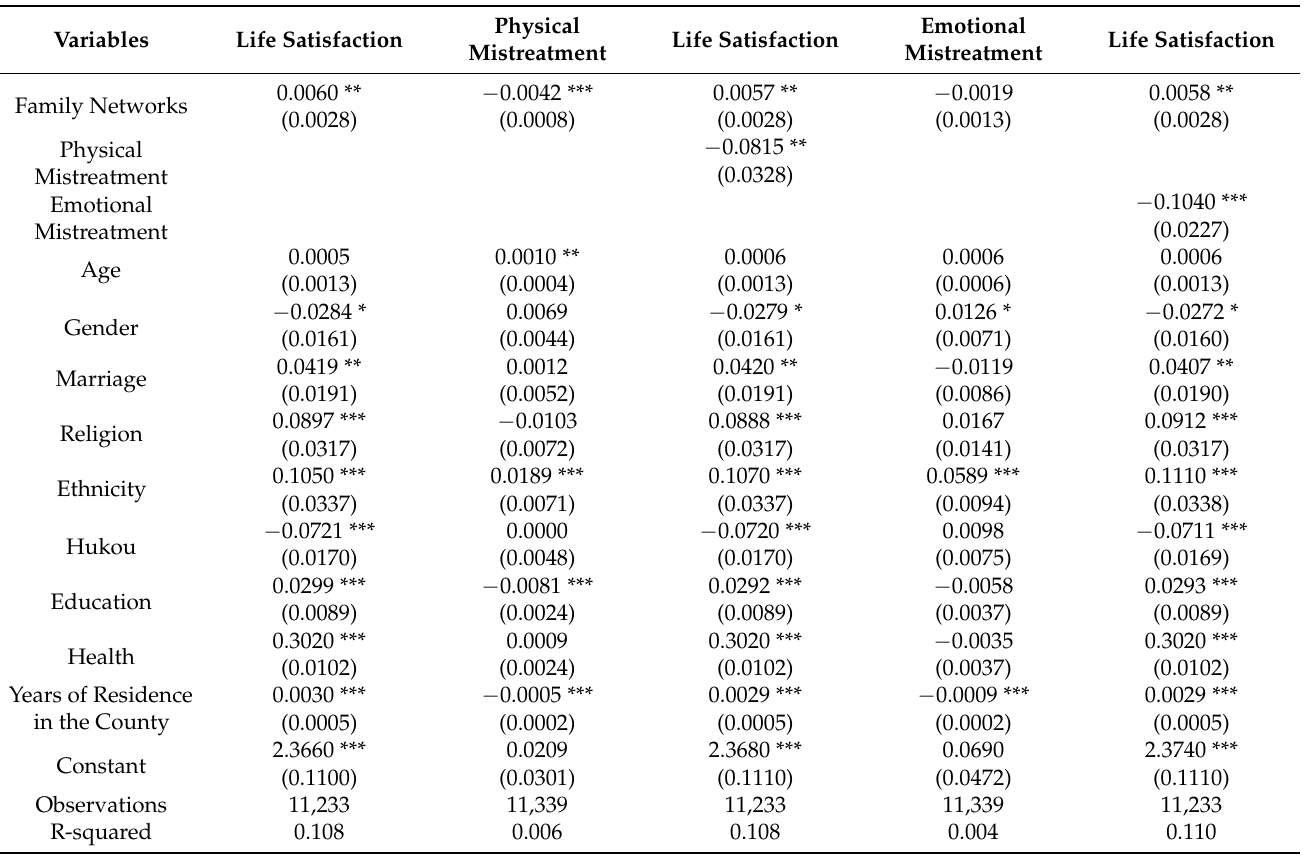
Table 5. Test of the mediating effect of family